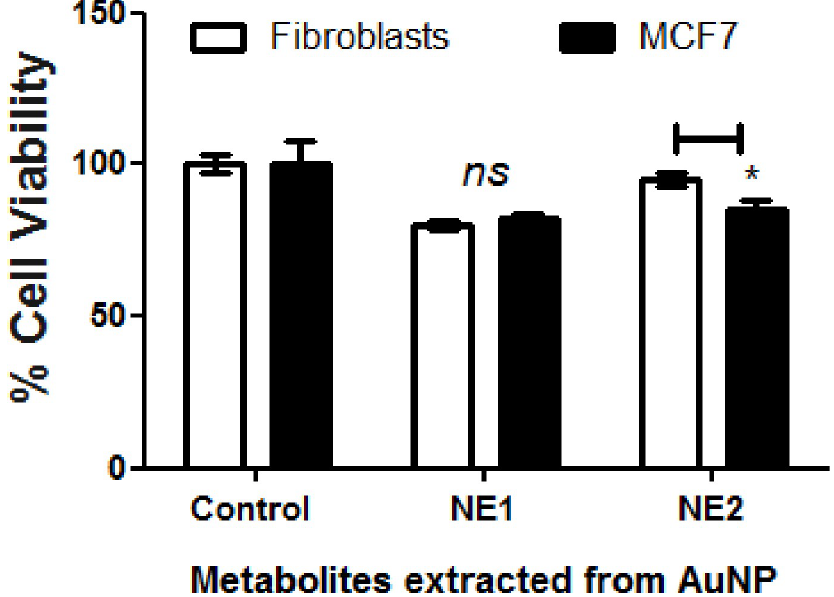
Fig 8. Cytotoxic activities of metabolites extracted from AuNPs. NPs solution was centrifuged and the NPs were collected and washed by PBS two times prior to extraction using methanol and sonication for 15 min. The extracted metabolites were tested on F180 and MCF7 cells using MTT assay. Mammalian cells were seeded in 96-well plate until confluency followed by incubation with the samples overnight prior to MTT assay. The data were analyzed using two- way ANOVA and statistical significance was calculated with Bonferroni’s multiple comparisons test and significance levels were indicated by asterisks ( � , P < 0.05; �� , P < 0.01: ��� , P < 0.001; ���� , P < 0.0001). The data display the mean of the percentage of the survival rate of mammalian cells ± SEM of 5